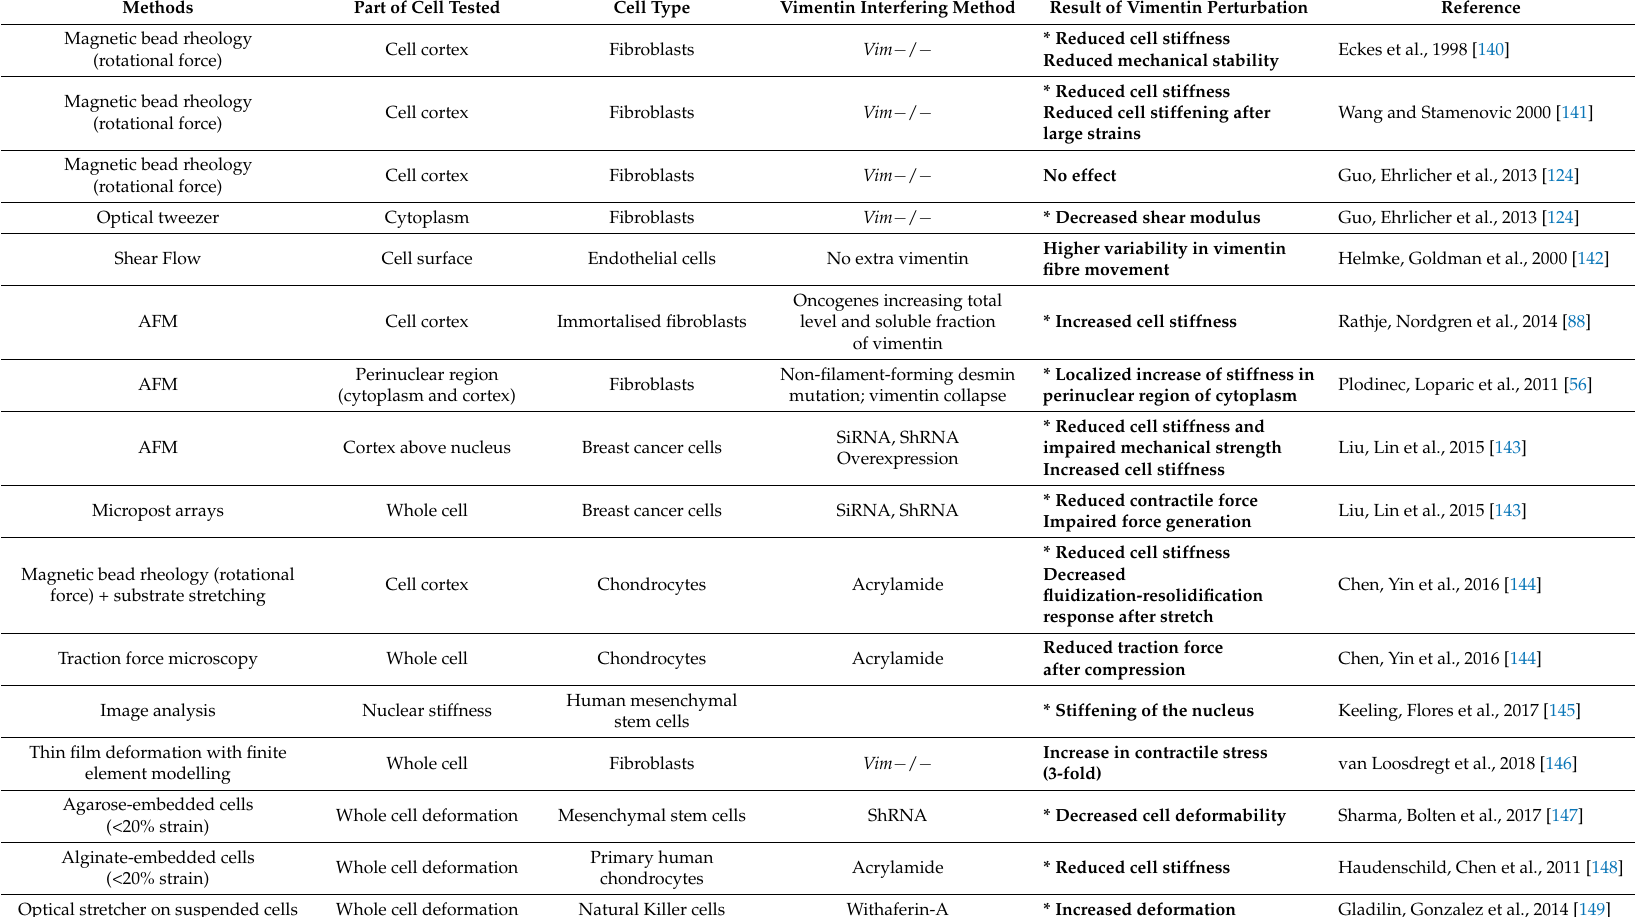
Table 2. Publications measuring mechanical properties of cells depending on vimentin, classified according to the measurement method. Cells were adhered to an underlying substrate if not described otherwise. An asterisk indicates studies showing that vimentin levels correlate with